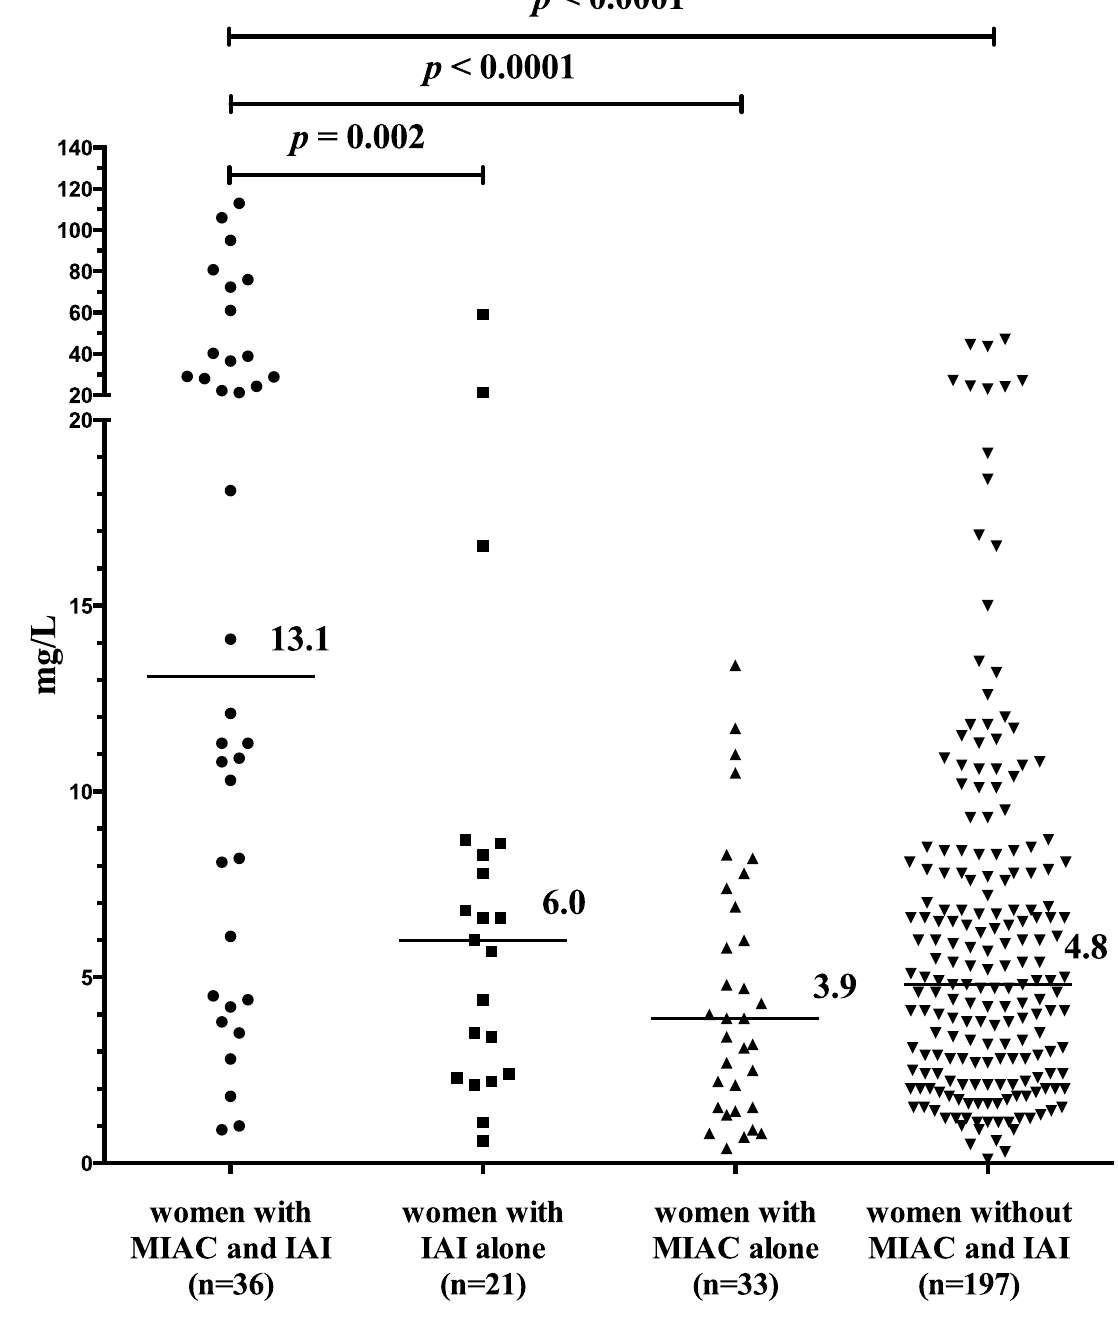
Fig 2. Maternal serum C-reactiveprotein concentrations in PPROM pregnancies complicated by the presenceof MIAC and/or IAI. Women with both MIAC and IAI had highermaternalserum C-reactiveprotein concentrations than did women in other subgroups. Abbreviations: MIAC, microbialinvasionof the amniotic cavity; IAI, intra-amniotic inflammation.